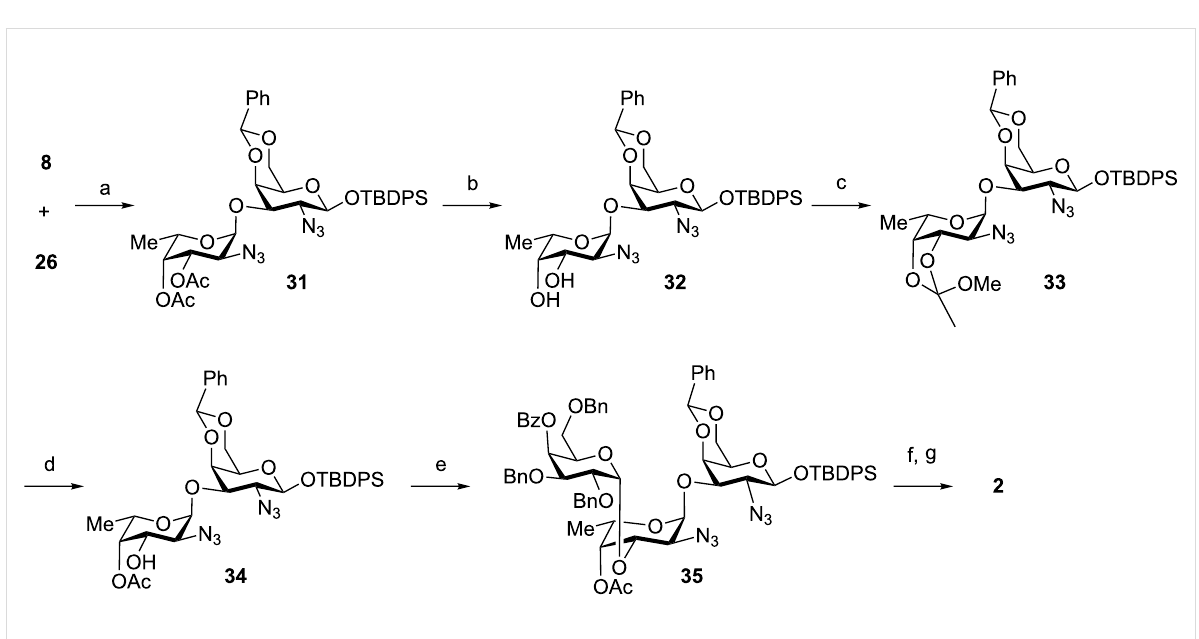
Scheme 6: Synthesis of the non-reducing end trisaccharide 2 . Reagents and conditions: (a) TMSOTf, CH 2 Cl 2 , − 30 °C, 74%; (b) NaOMe (0.5 M in MeOH), MeOH, rt; (c) trimethyl orthoacetate, p -TsOH, toluene; (d) 80% AcOH, rt, 71% over three steps; (e) 9 , NIS, TMSOTf, dioxane/toluene (3:1), − 10 °C, 54%; (f) HF-pyridine, THF, 0 °C; (g) CCl 3 CN, DBU, CH 2 Cl 2 , 0 °C, 57% over two steps.